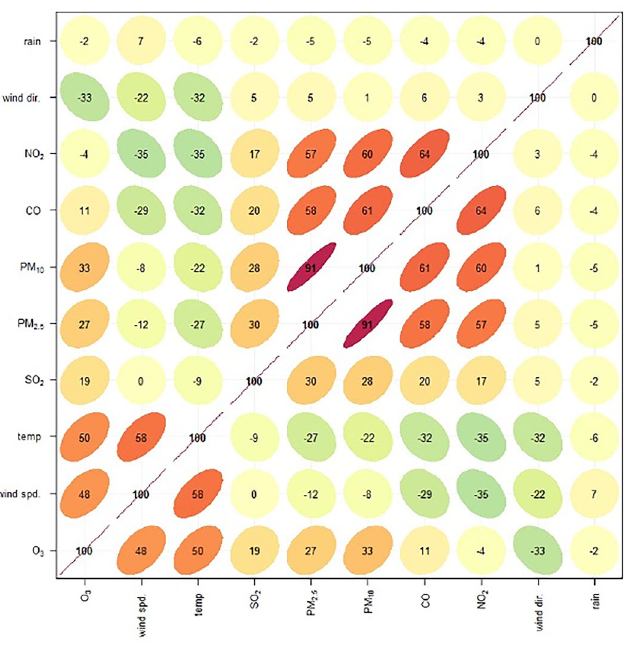
Figure 1. Spearman rank correlations between PM 2.5 concentrations and levels of other air quality parameters.